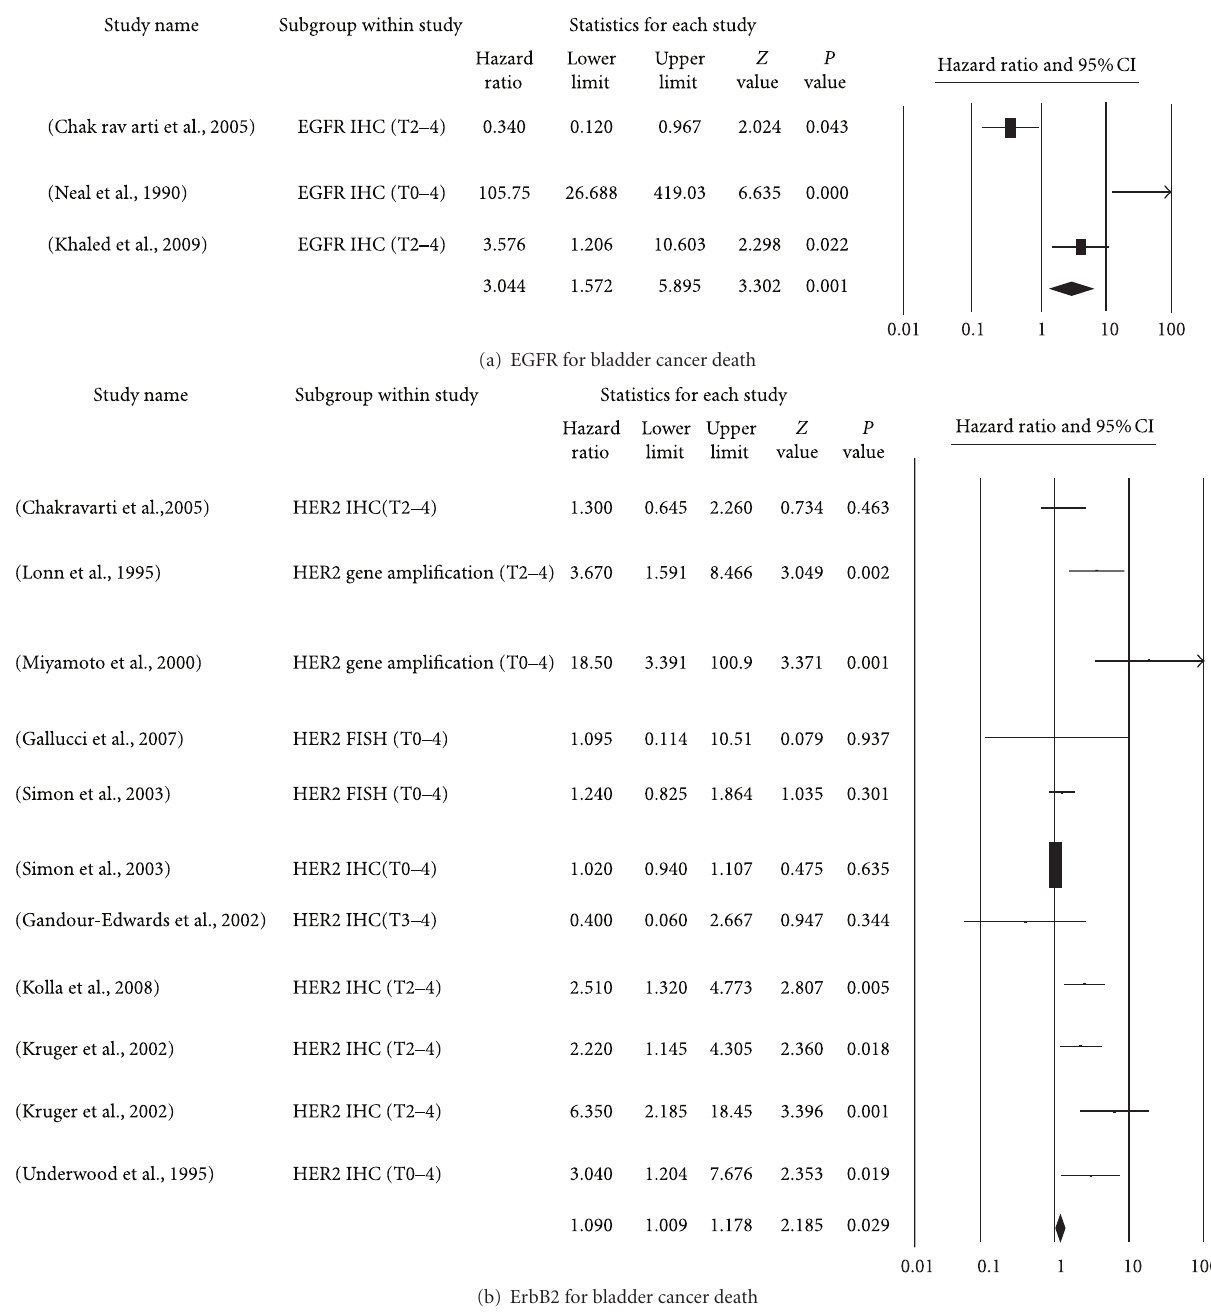
Figure 2: Forest plots of prognostic significance of EGFR and ErbB2 overexpression on bladder cancer death. (a) EGFR. (b) ErbB2. Hazard ratios and 95% (confidence intervals) CIs for patients with either EGFR- or ErbB2-positive